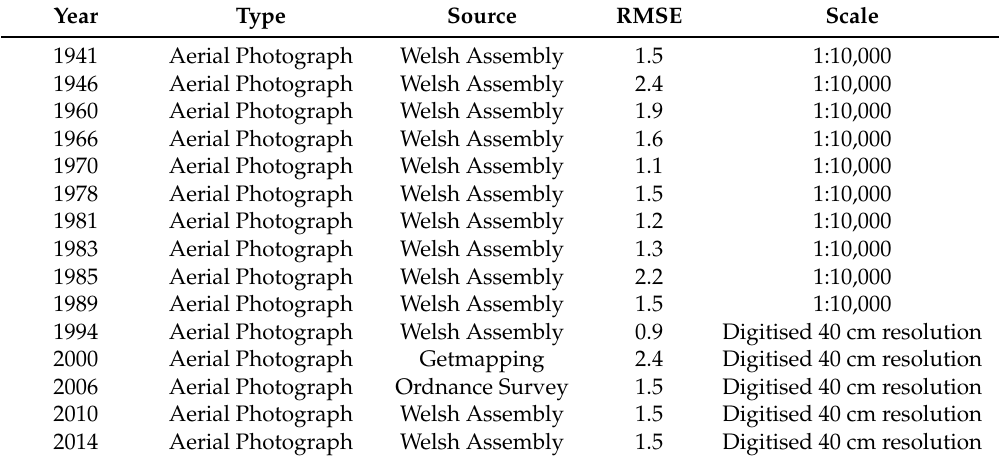
Table 1. Aerial photographic source document scales and RMSE results after